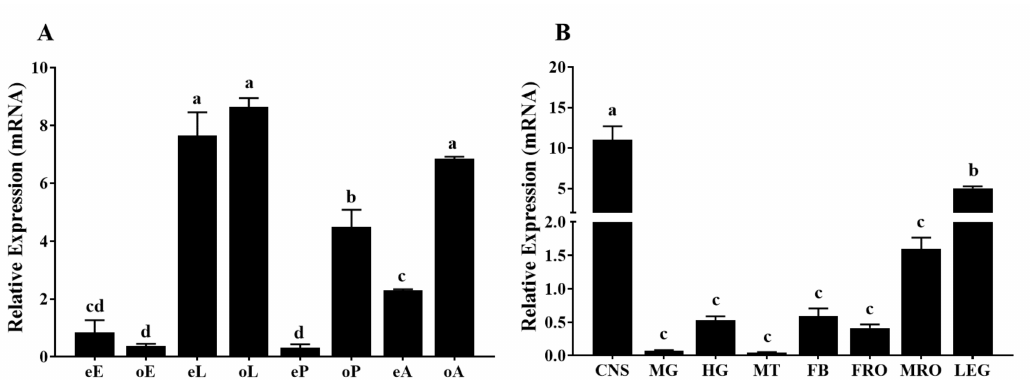
Figure 4. ( A ) Relative expression levels of TcOct β 2R at different developmental stages. Different stages are denoted by capitalized letters: E (egg), L (larva), P (pupa), and A (adult). Letters in lowercase e and o represent early and old, respectively; ( B ) relative expression levels of TcOct β 2R in various tissues of adults. CNS, central nervous system; FB, fat body; MG, midgut; MT, Malpighian tubules; FRO, female reproductive organs; MRO, male reproductive organs; LEG, legs. All the data shown are means of the relative expression ± standard error (S.E.) ( n = 4), normalized to RPS3 transcript levels. Different letters on the bar represent a significant difference in ANOVA (Tukey, p <